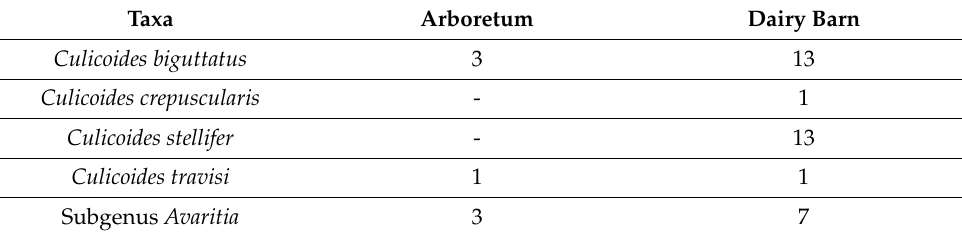
Table 1. Culicoides taxonomic rank and abundance based on morphological